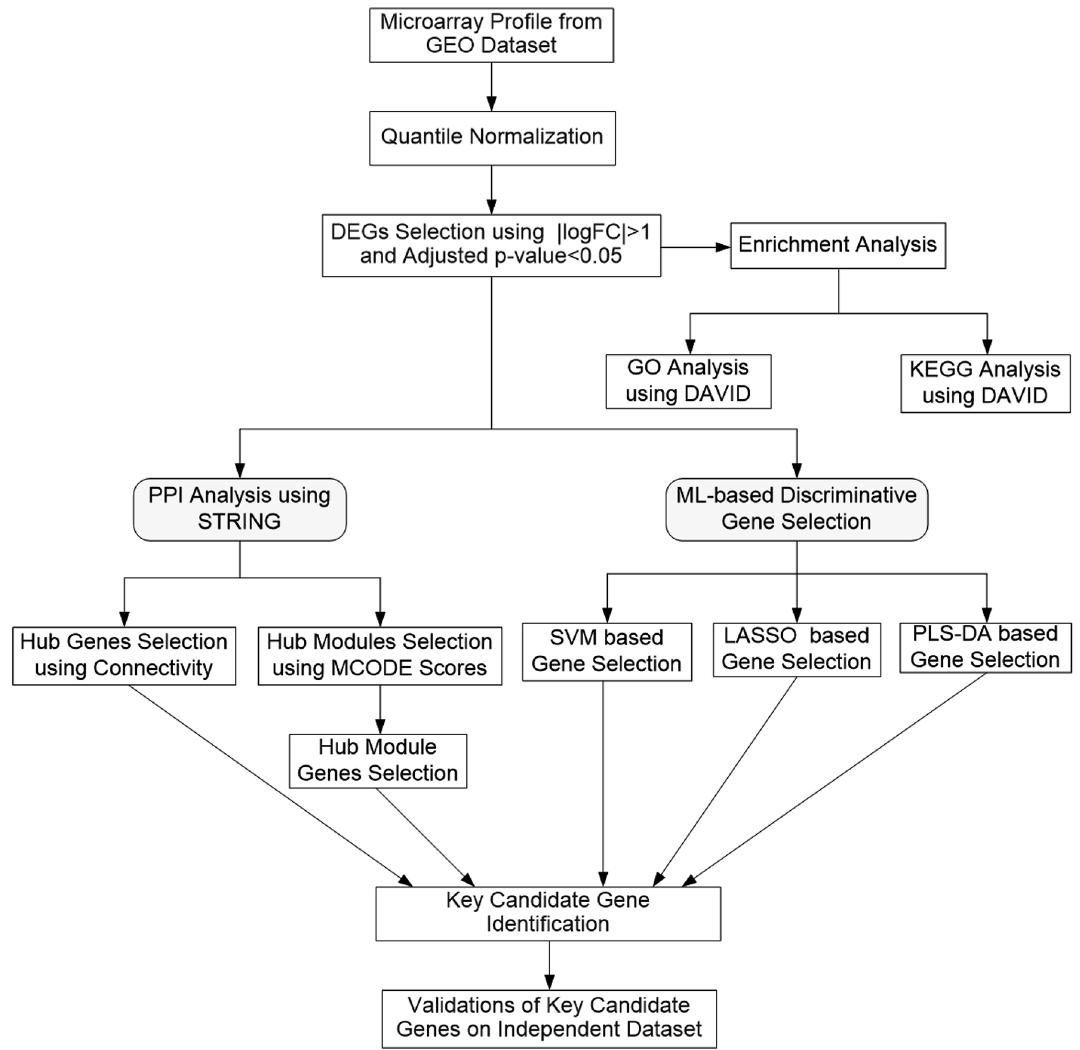
Figure 1. Flowchart of data preparation, processing, analysis, and